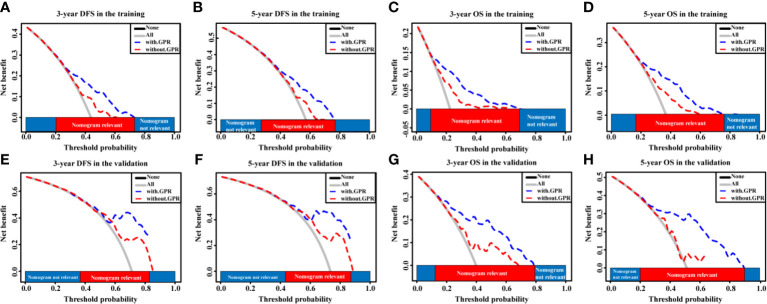
The DCA curves of the nomogram models with and without the GPR for HCC patients. (A–D) DCA curves showing the clinical utility of the nomogram models with and without the GPR for the 3-year DFS (A) and OS (C) rates and 5-year DFS (B) and OS (D) rates in the training cohort. (E–H) DCA curves showing the clinical utility of the nomogram models with and without the GPR for the 3-year DFS (E) and OS (G) rates and 5-year DFS (F) and OS (H) rates in the validation cohort. GPR, gamma‐glutamyl transpeptidase‐to‐platelet ratio; ALB, albumin; DCA, decision curves analysis; HCC, hepatocellular carcinoma; DFS, disease-free survival; OS, overall survival.